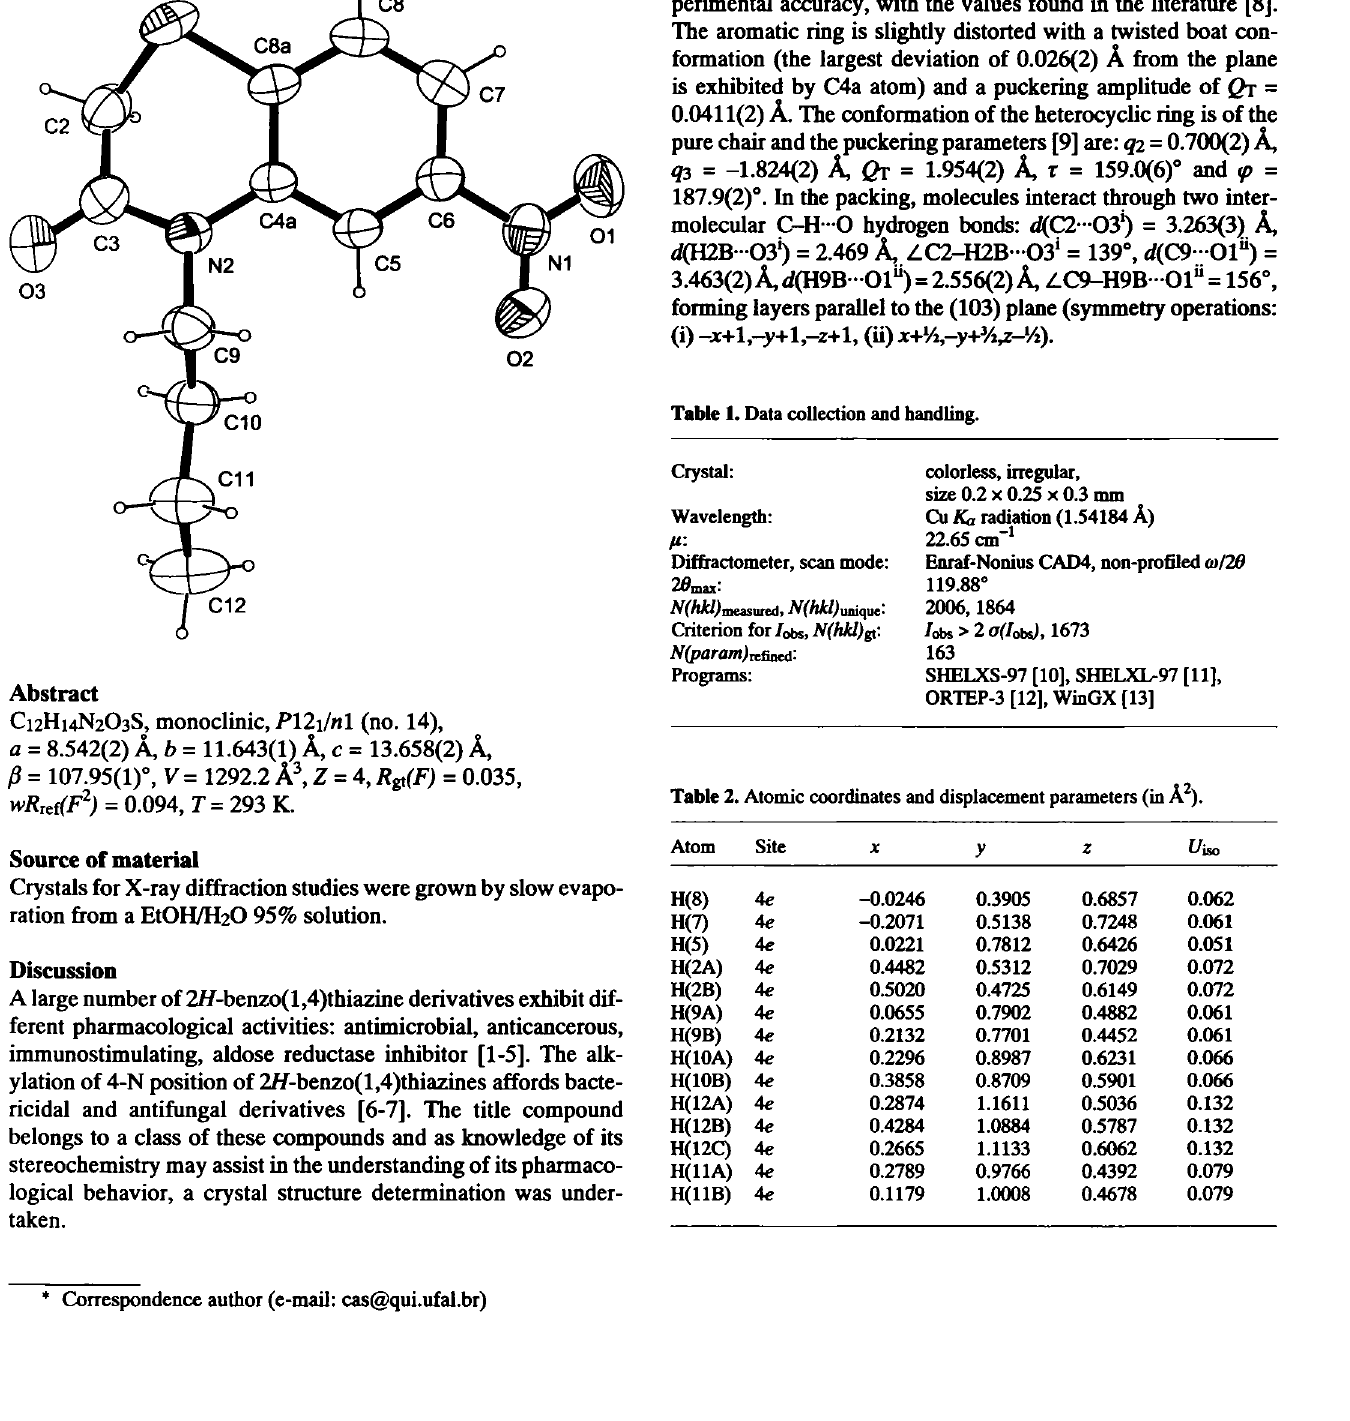
Table 2. Atomic coordinates and displacement parameters (in A 2